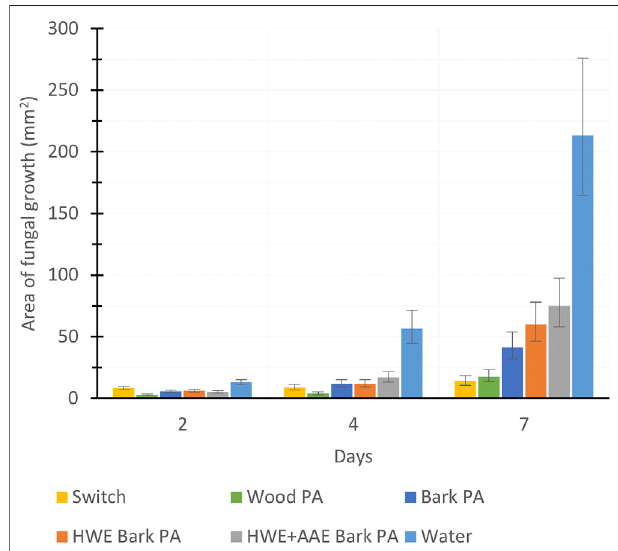
FIGURE 7 | Herbicidal effectivity of pyroligneous acids (PAs) produced from wood and variously treated ( HWE , hot water extracted; AAE , alkaline alcohol extraction) bark products (mean ± SD, n = 4) against Brassica rapa seedlings 7 days after the spraying compared to that of a commercial product (BioNeko) and water controls.